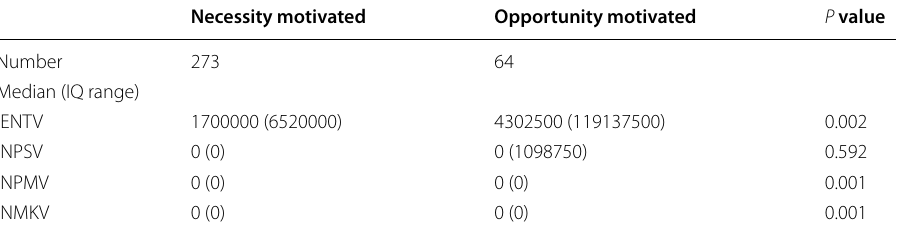
Table 6 Differences between necessity-motivated enterprises and opportunity-motivated enterprises in the value of innovations carried out